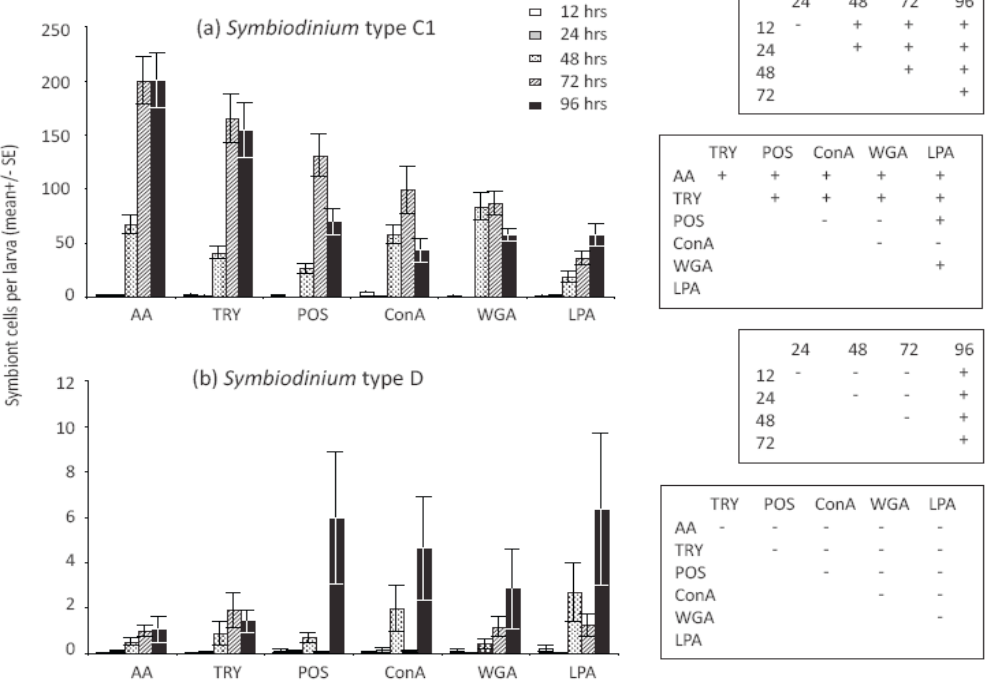
Figure 3. Representative confocal images of lectin-labelled (as indicated by green fluorescence) and unmodified (control) Symbiodinium cells for the following treatments to C1/D cells: ( a/f ) unmodified control cells; ( b/g ) ConA treated cells; ( c/h ) ConA plus inhibitor treated cells; ( d/i ) WGA treated cells; and ( e/j ) WGA + inhibitor treated cells. Percent of cells labelled indicated in bottom right corner All scale bars = 10